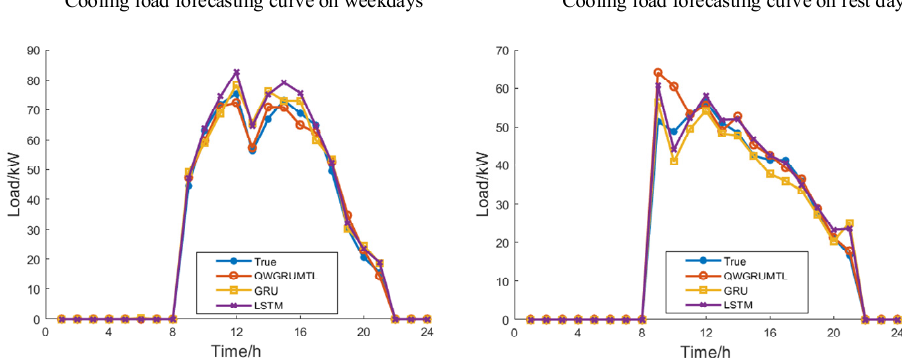
Figure 9. Forecasting curve of cooling load in summer.